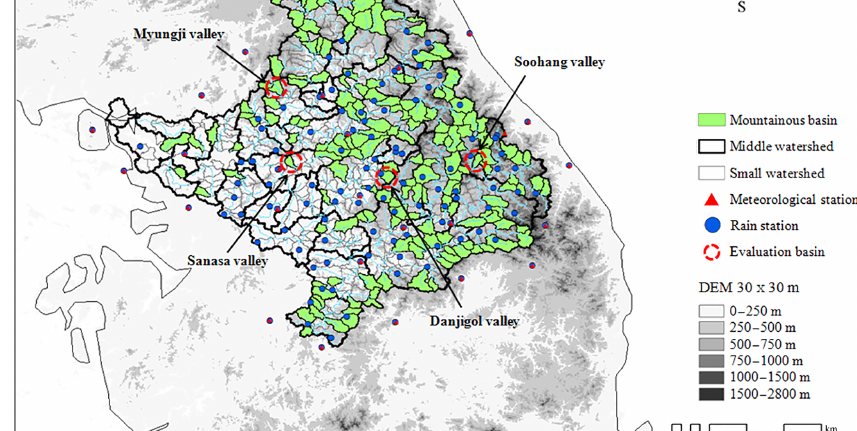
Figure 1. Study area.